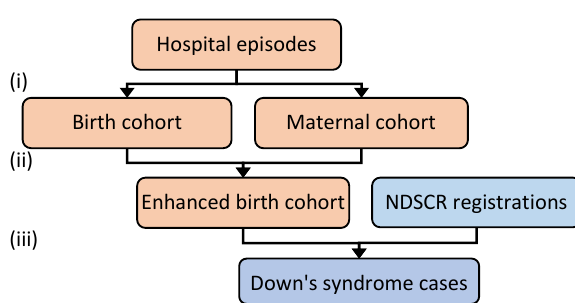
Figure 1: Linkage overview